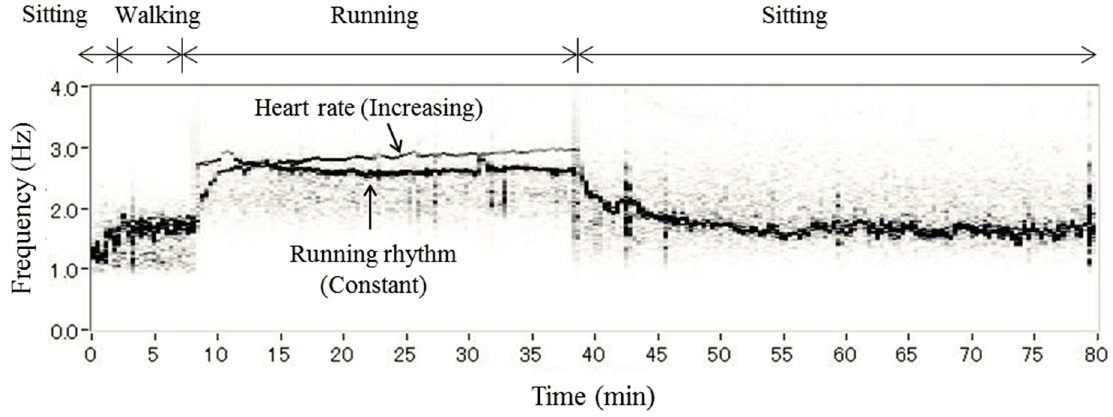
Figure 5. Frequency of blood flow while running. Typical example of the time-spectrum distribution of blood flow at the forehead while a subject ran at 10 km/h. The black color depth represents the intensity. These spectra were obtained by performing FFTs on blood flow signal data lasting for 40.96 s (2048 points). Band-pass filters from 1.0 to 2.0 Hz during the first sitting and walking period, from 2.0 to 3.5 Hz during running, and from 1.5 to 3.5 Hz during the second sitting period were